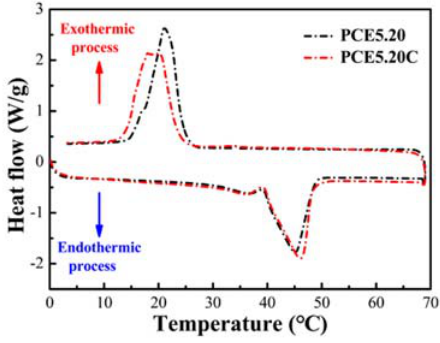
Figure 10. DSC curves of PCE5.20 before and after 100 thermal cycles.